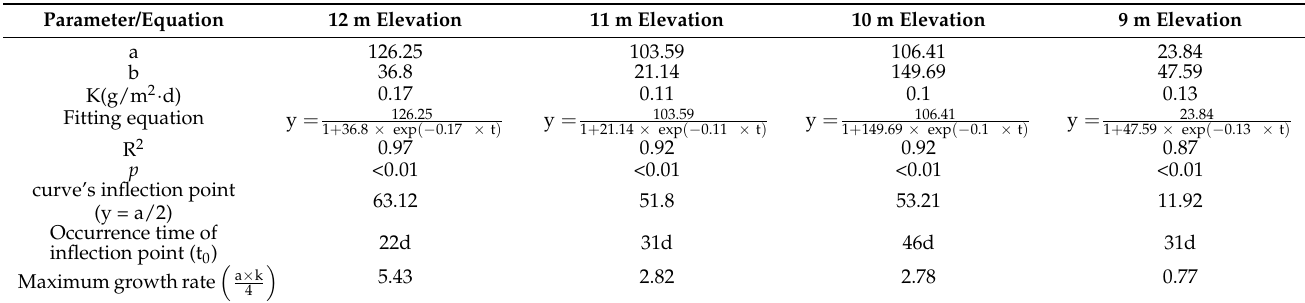
Figure 6. Polygonum criopolitanum Logistic regression population growth curves in different elevation zones ( A ) represents 12 meter elevation, ( B ) represents 11 meter elevation, ( C ) represents 10 meter elevation, ( D ) represents 9 meter elevation. Table 2. Logistic equation fitting